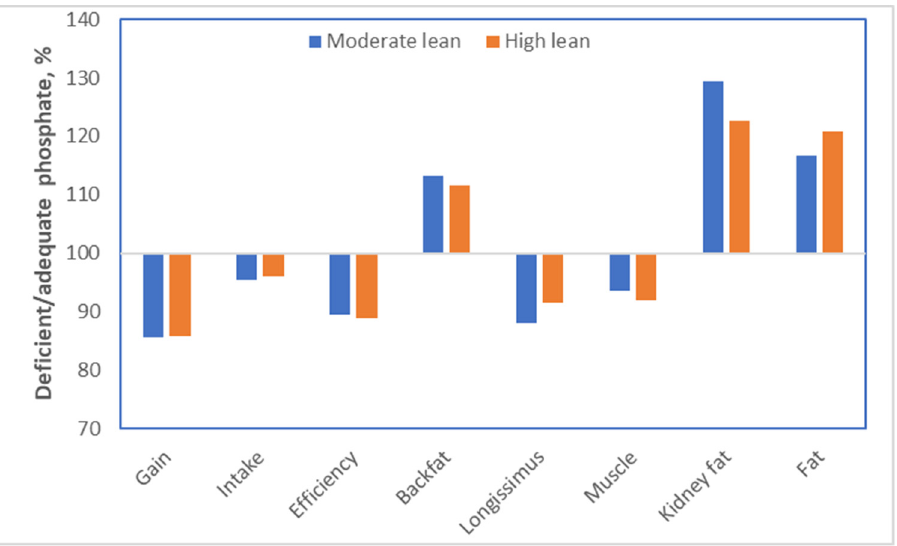
Figure 12. Effect of diets deficient in phosphate versus adequate amounts on performance and body composition using a moderate and a high lean genetic line of pigs [30].